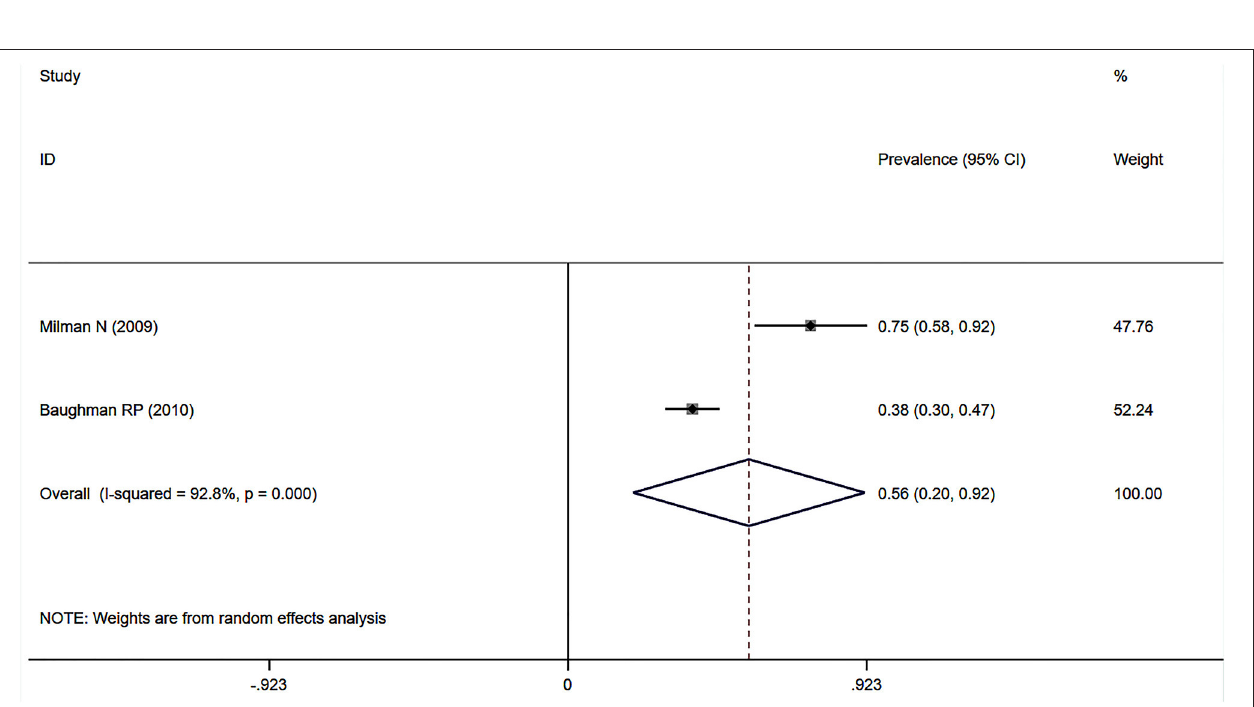
FIGURE 7 | Forest plot of the pooled prevalence of pre-capillary PH by RHC in the population with advanced sarcoidosis. PH, pulmonary hypertension; RHC, right heart catheterization.